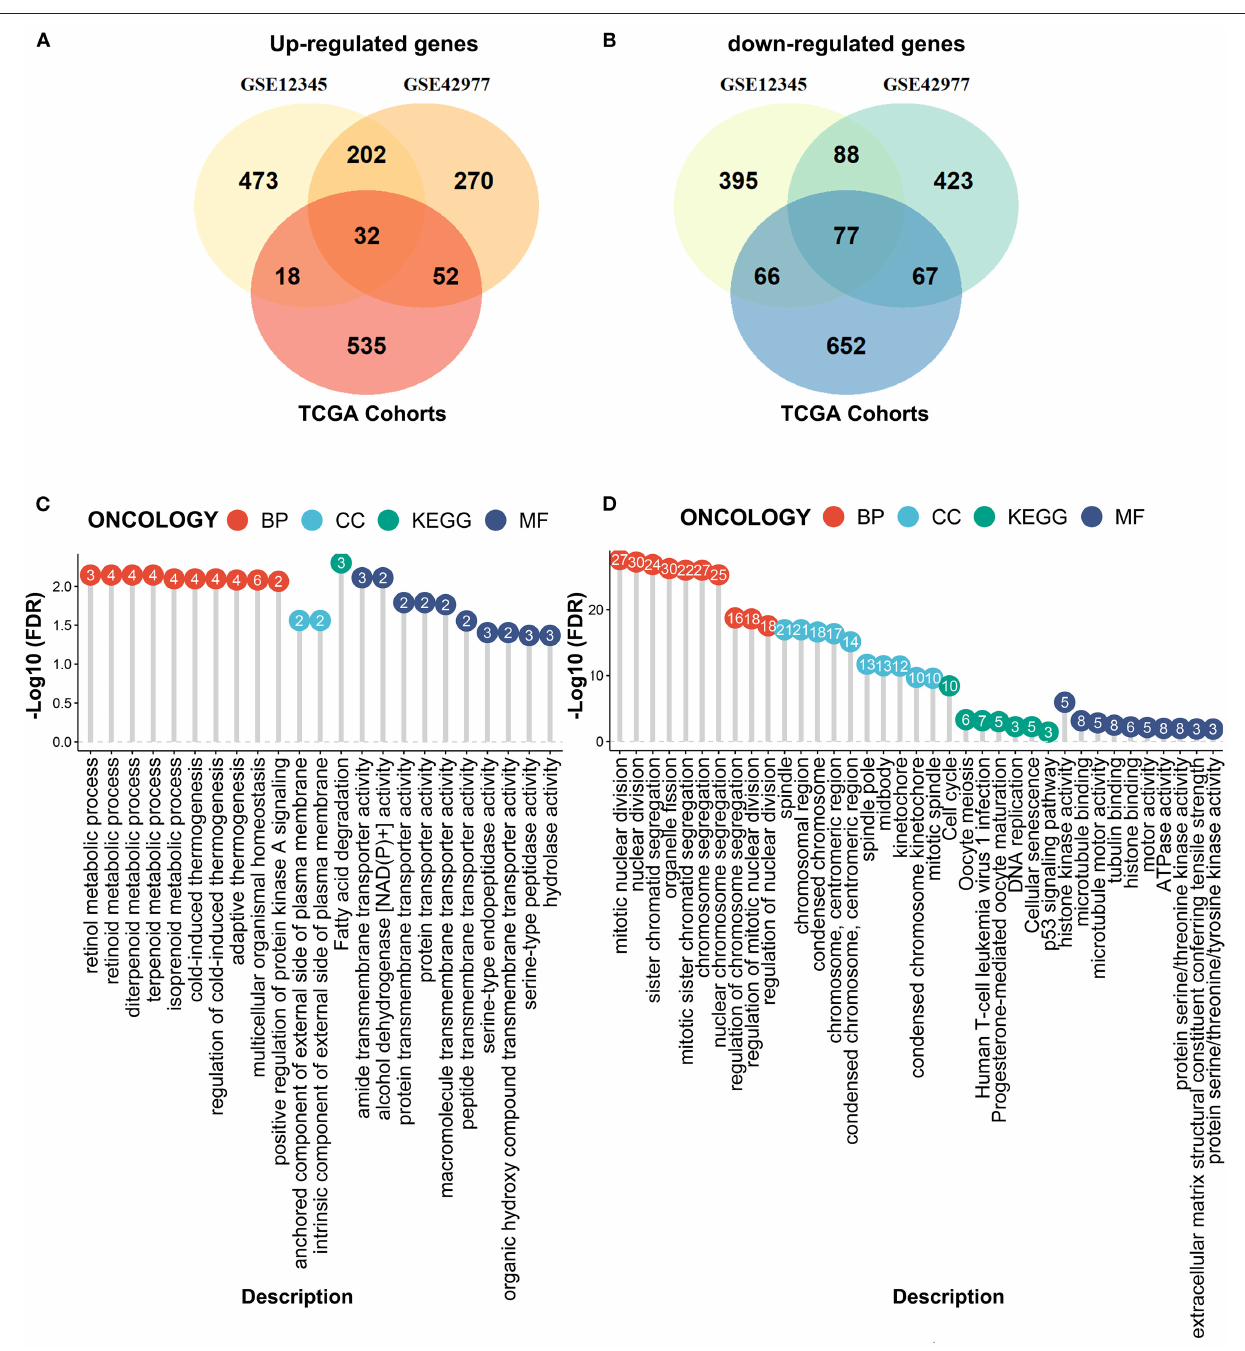
Frontiers in Oncology |